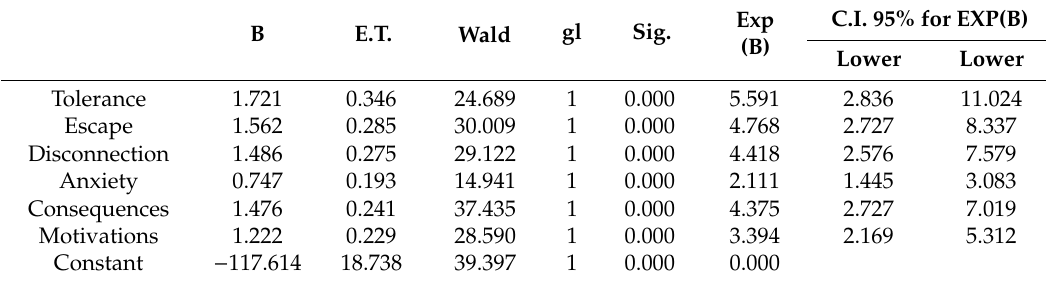
Table 12. Binary logistic regression of the self-perception on the problematic smartphone use a of students older than 26 years old with respect to the MPPUSA.